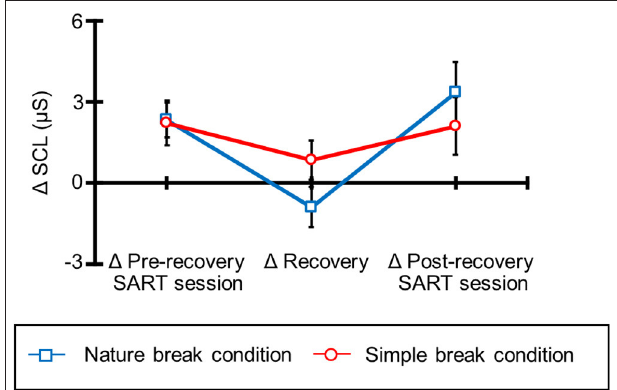
FIGURE 5 | 1 SCL and standard error of 1 SCL for each simple and nature break conditions.